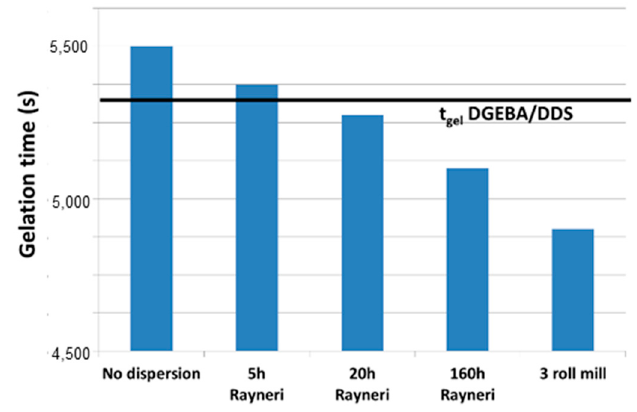
Figure 8. Gel time evolution as a function of the mixing conditions for the reactive system epoxy/amine/MWNT (0.7 wt %) at 150 °C.